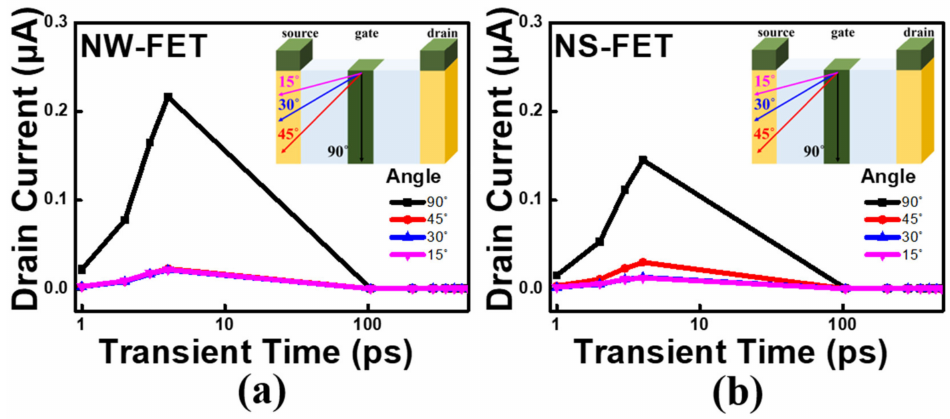
Figure 4. Change in drain current as the particle strikes the gate and moves toward the source in the ( a ) NW-FET; ( b ) NS-FET.